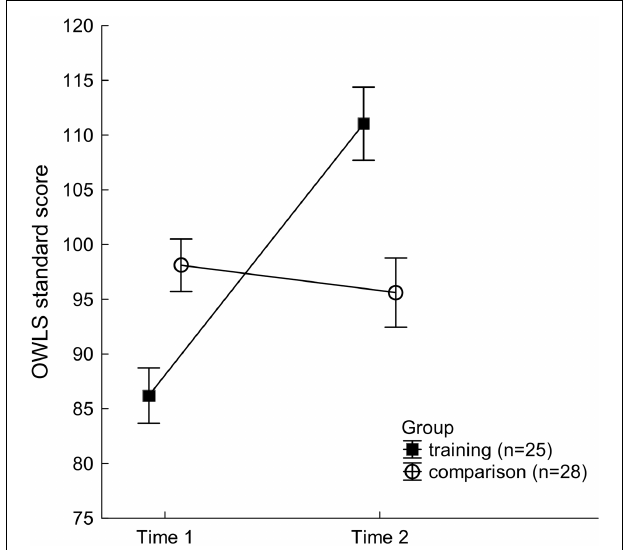
FIGURE 2 |Written Expression Scale standard scores of the Oral and Written Language Scales (OWLS) for the two participant groups at Time 1 andTime 2. Mean values of 25 training group participants (filled squares) and 28 comparison participants (open circles) are shown.Vertical bars indicate standard errors of mean.While the training group students were outperformed by the comparison group atTime 1, their considerable spurt in writing following intervention, led to a reversed performance pattern atTime 2, with lower standard scores in the non-trained students.